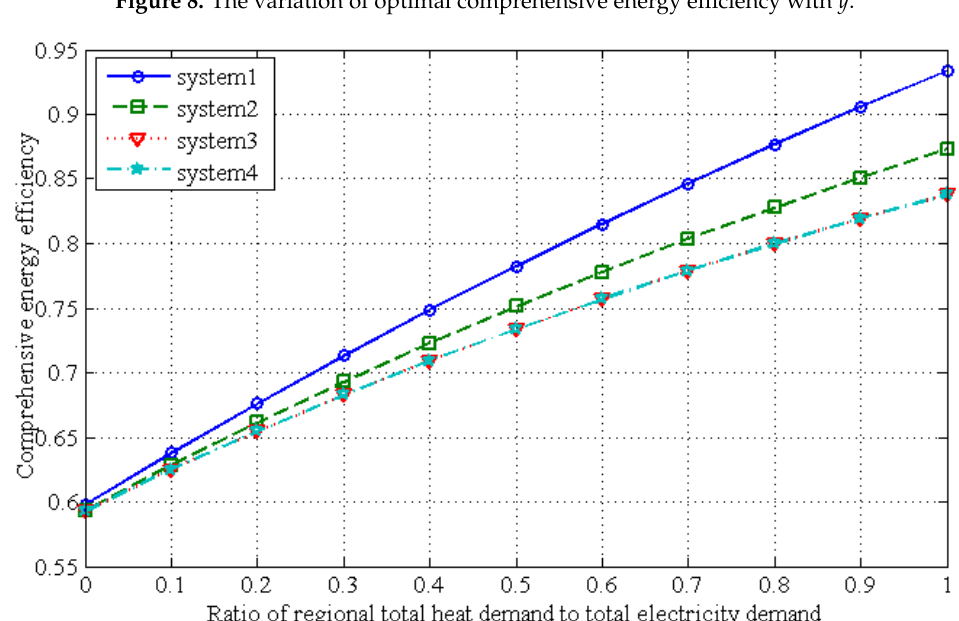
Figure 9. The variation of optimal comprehensive energy efficiency with z.